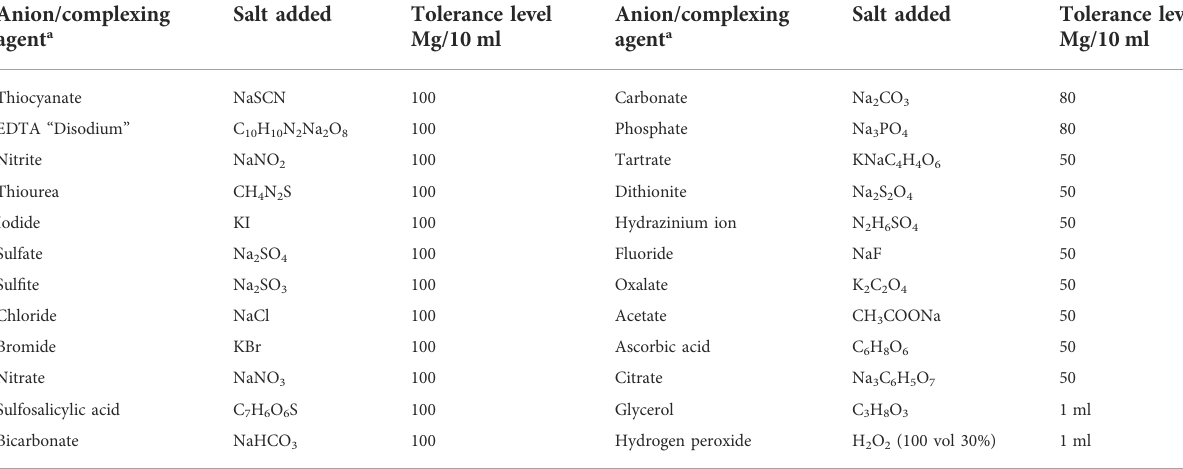
TABLE 2 Impact of anions/complexing agents on the Ir (III)-CHMTB complex.